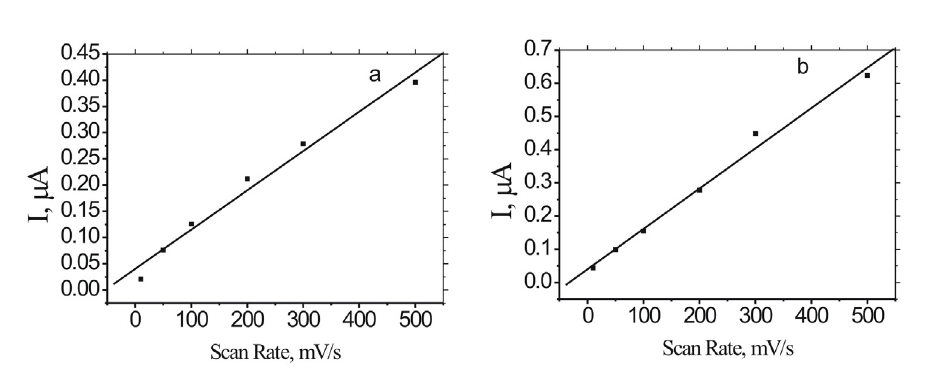
Figure 3. Effect of scan rate on peak current of MB at the ds-DNA/Au (a) and ss-DNA/Au (b)